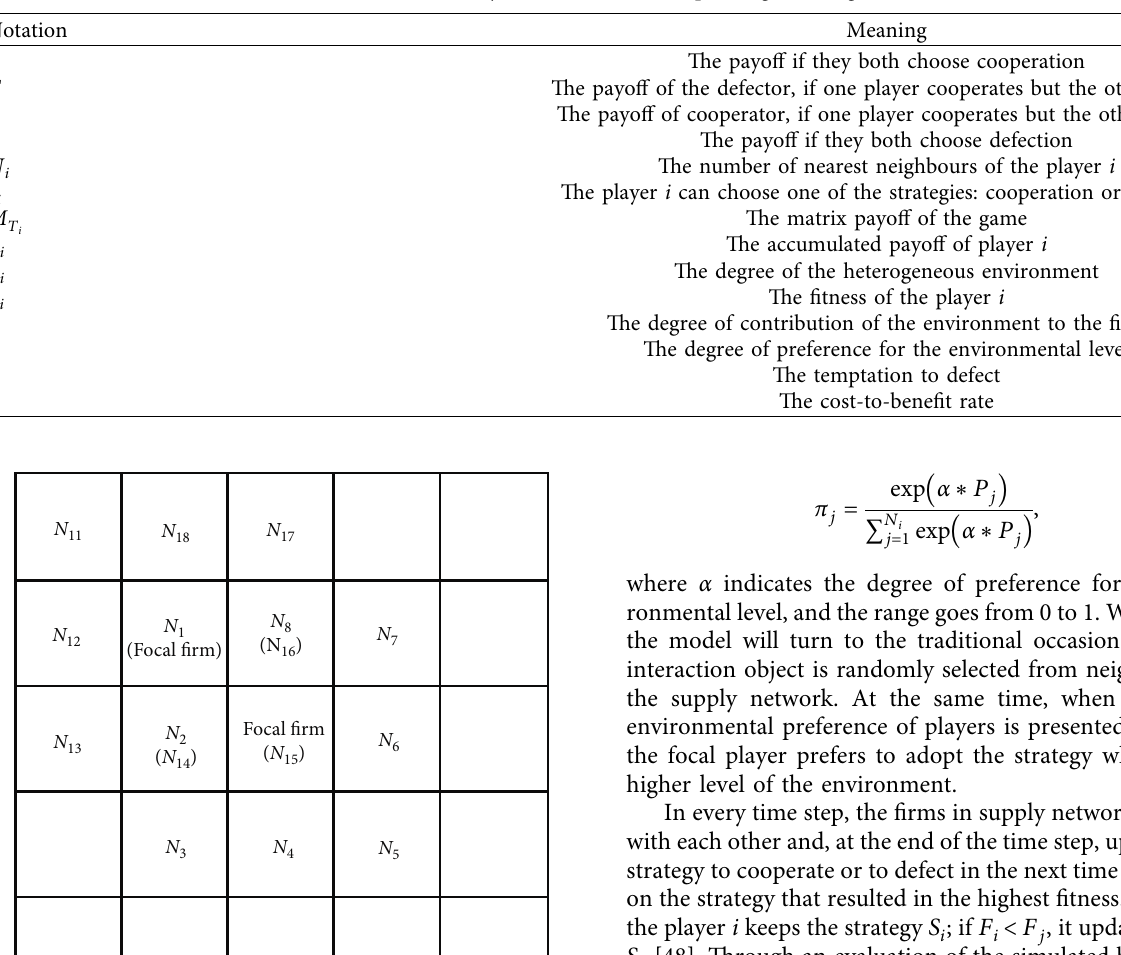
Table 1: Some symbols and the corresponding meanings.